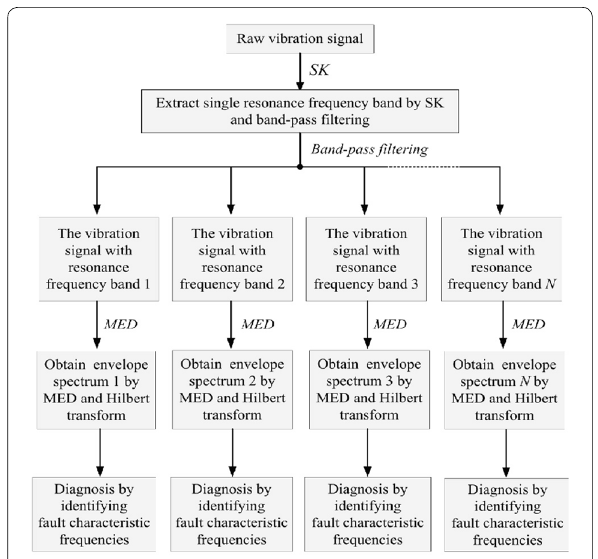
Figure 10 Technical process of He et al.